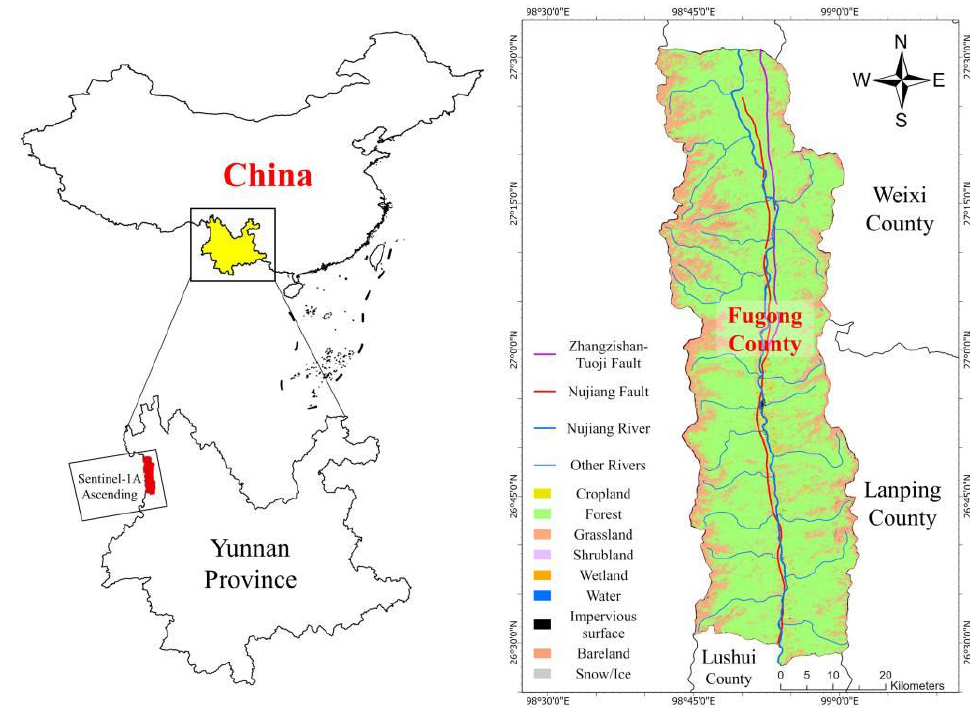
Figure 1. The location and land cover of the study area.